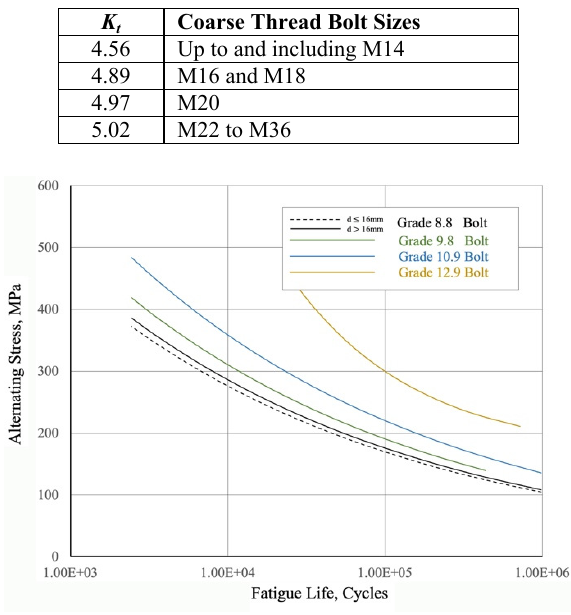
Figure 3. S-N curves for stress concentration K t = 4.56